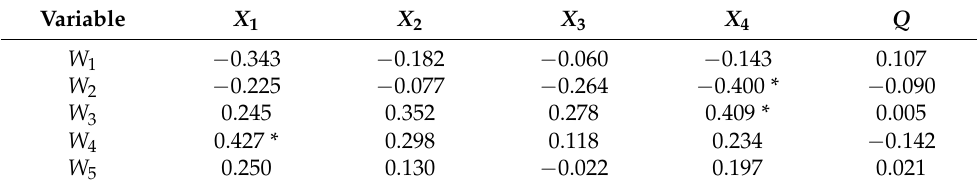
Table 6. Correlations between selected indicators in 2020.